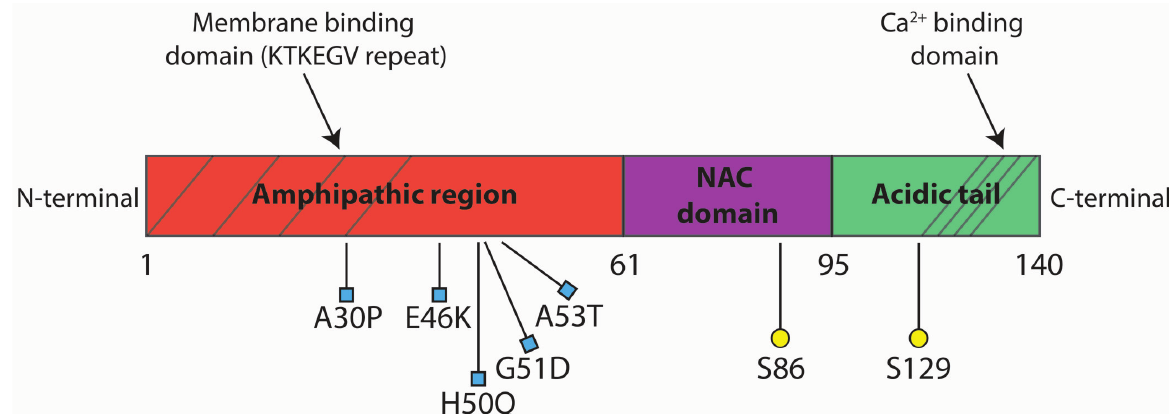
Figure 1. Structure of the (cid:2)Syn protein. The N-terminal domain (red) is composed of KTKEGV repeats where human missense mutations associated to familial PD have been found. The central hydrophobic core (purple) is called NAC domain and promote aggregation of the protein. The C-terminal domain (green) is the acidic tail that contains phosphorylation sites and the calcium binding